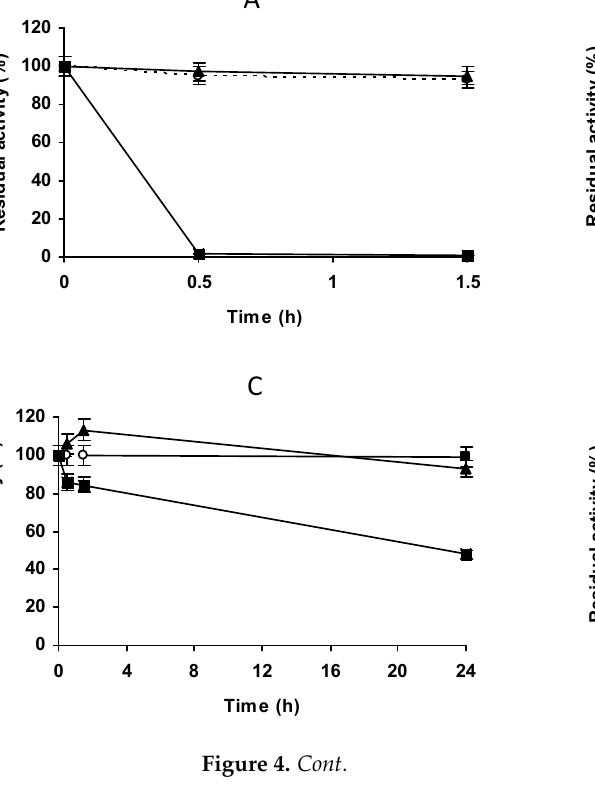
E Figure 4. Cont